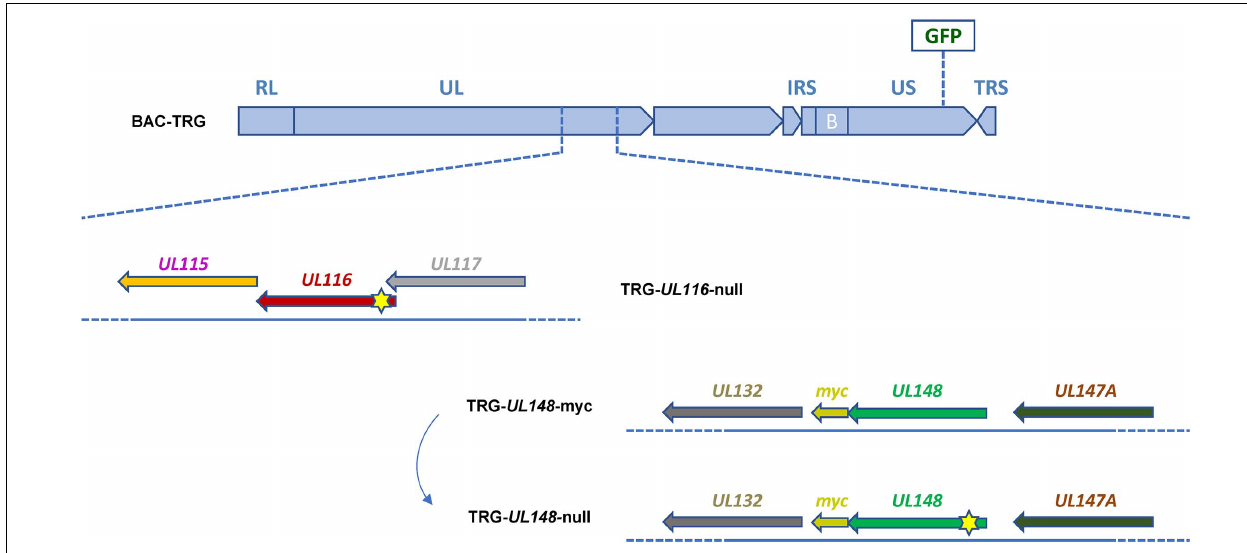
FIGURE 1 | Schematic representation of recombinant HCMV mutants generated. Each mutant is generated through the BAC Mutagenesis Technique. The backbone sequence, common for each mutant shown, consists of the HCMV TR-wt strain cloned into a BAC containing a GFP CDS insertion under control of an Immediate Early CMV promoter, in an intergenic region between US32 and US33A genes (BAC-TRG). The TRG- UL116- null clone was generated using the BAC-TRG as template with a single nucleotide insertion in the CDS (between nucleotides in position 4–5) of the UL116 gene causing a frameshift and a STOP codon formation. The TRG-UL148-myc clone was generated using the BAC-TRG as template inserting the sequence encoding for a myc-tag in frame at Carboxy terminal. The TRG- UL148 -null clone was generated from the BAC-TRG-UL148-myc by mutation of the codon at position 4 into a STOP codon. Reconstitution of the infectious viruses was performed as detailed in M&M. Yellow stars indicate the approximative position of the stop codon insertion.